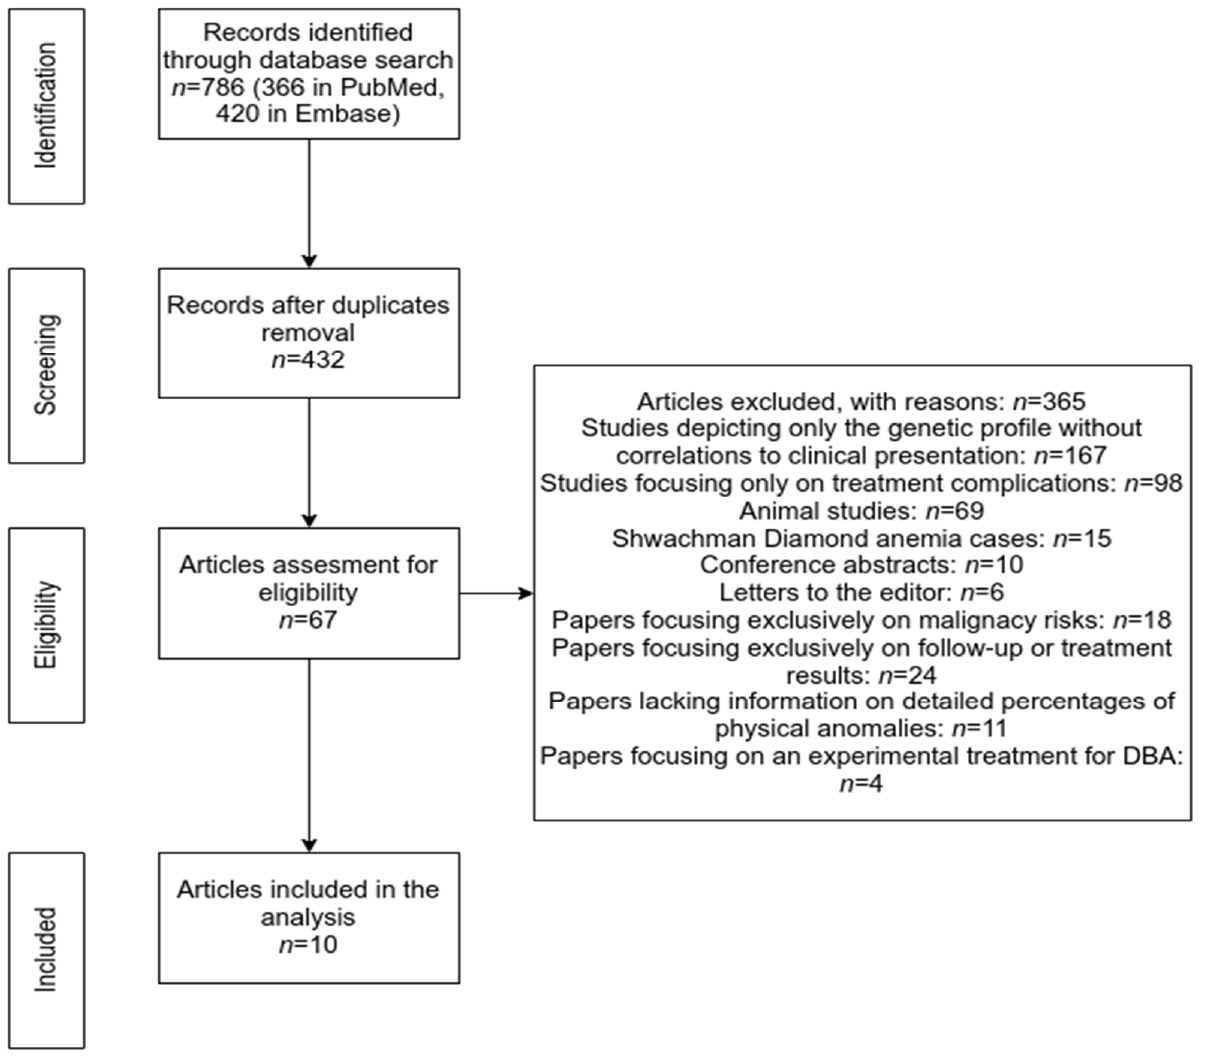
Figure 3. Prisma Flowchart (methodology).